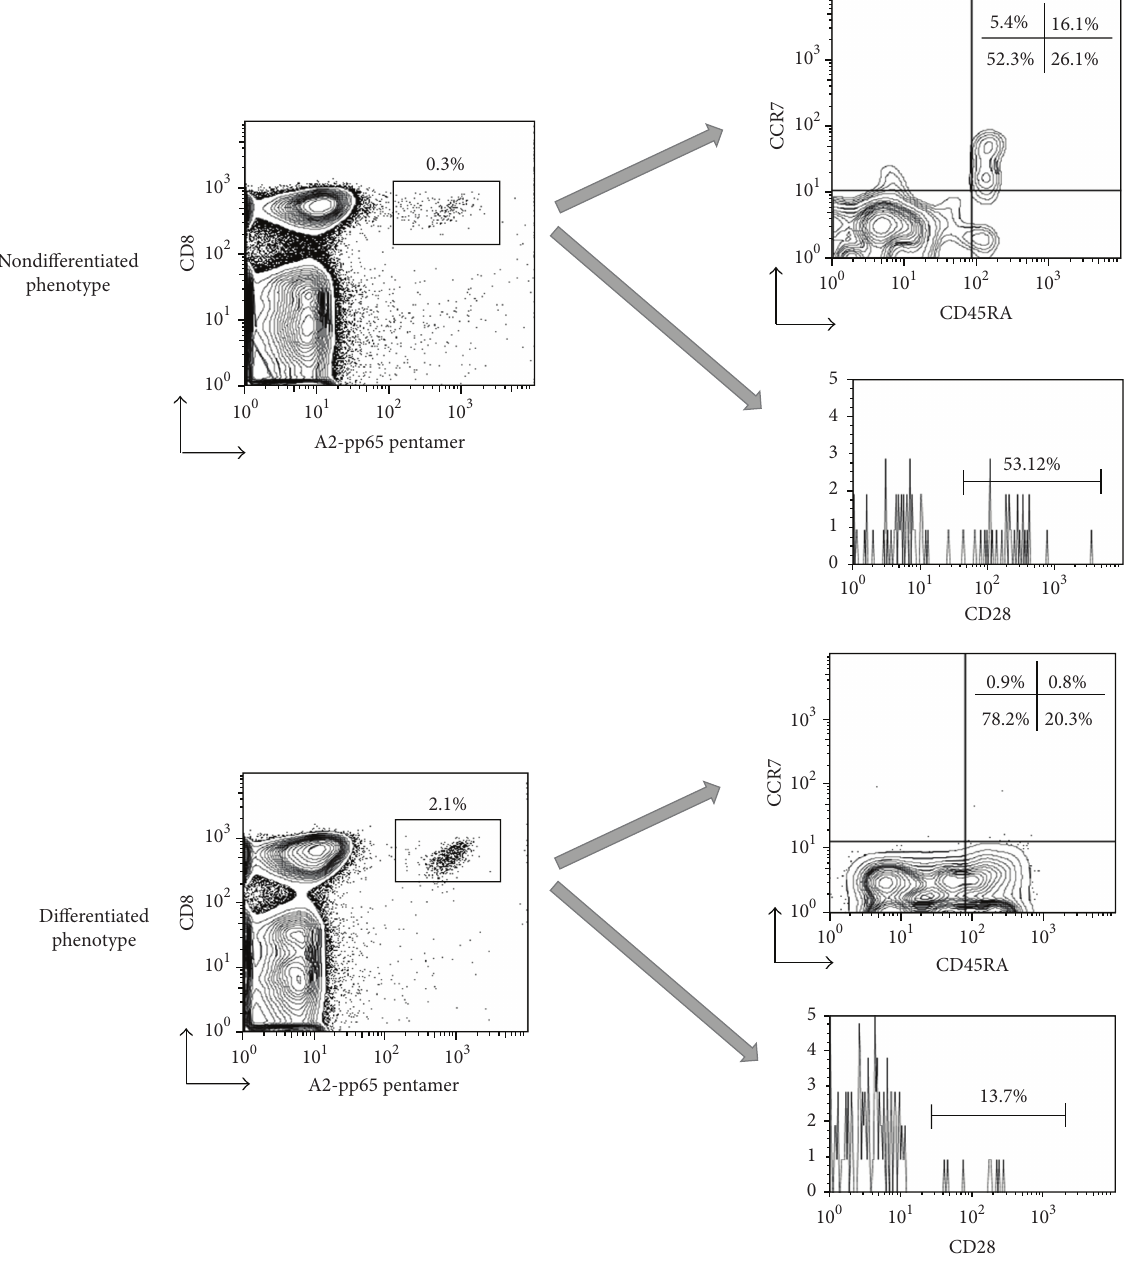
F1:�uantitativeassessmentofHCMV-speci�cTcellwith“differentiatedphenotype.”�uantitativeassessmentofHCMV-speci�cCD8� T cells using A2-pp�5 pentamer and monoclonal antibodies speci�c for CD8. e phenotype of HCMV-speci�c CD8� T cells was determined analyzing the expression of CCR7, CD45RA, and CD28. A representative example is